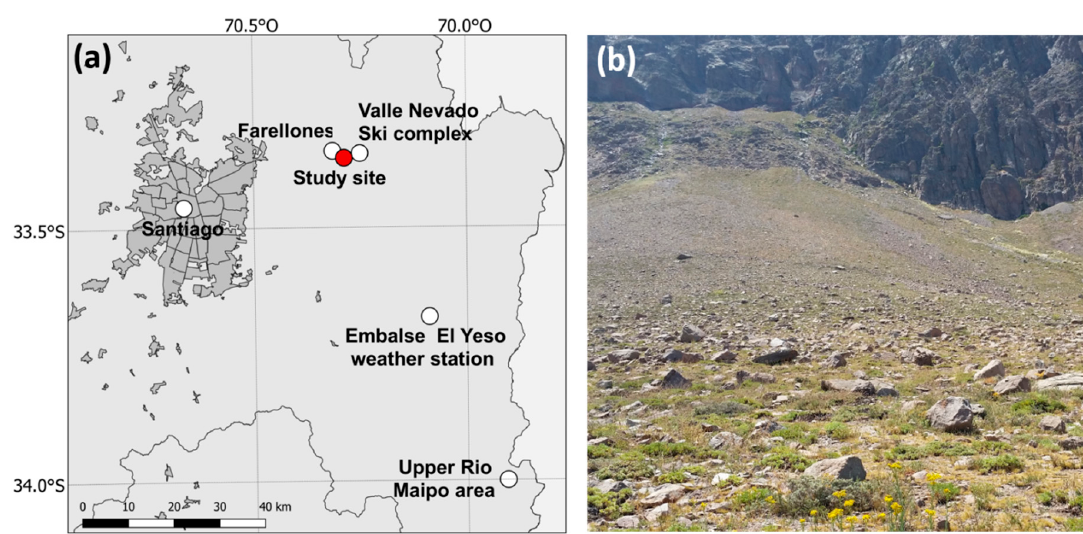
Figure 10. ( a ) Location the study site (red filled circle) at 2400–2450 m.a.s.l. in the Andes east of the city of Santiago, Metropolitan Region, Chile. Also shown are other localities mentioned in the text. ( b ) View of the subalpine slopes where the work was carried out. Image: Mary T. K. Arroyo, taken in Yr-1 on 21 February 2019.